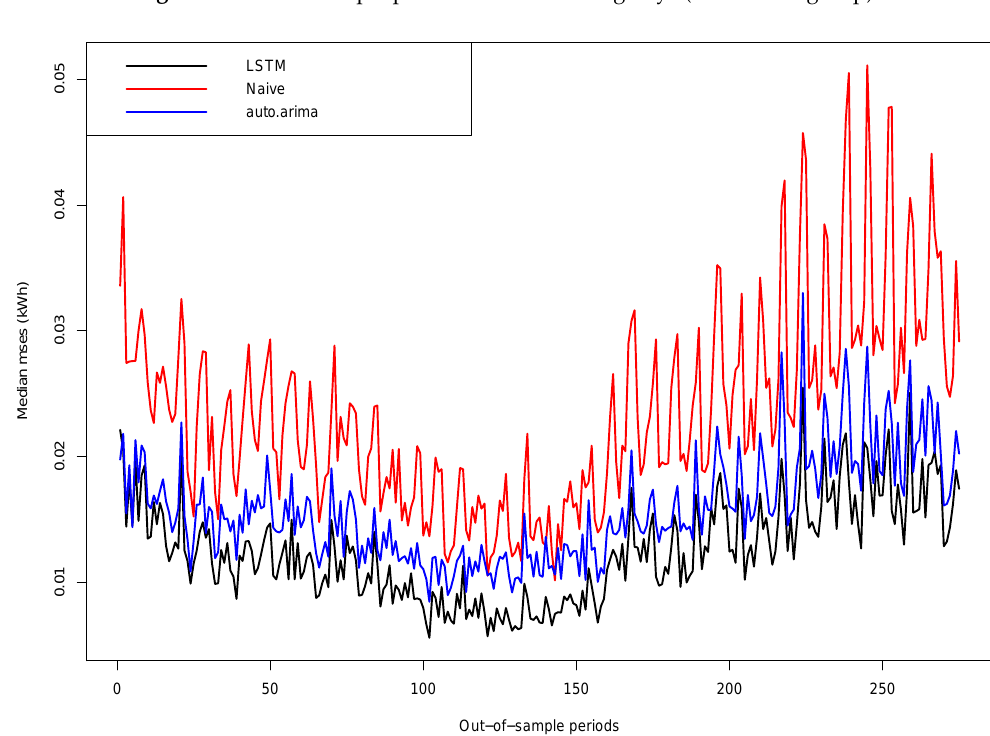
Figure 16. Out-of-sample performance for testing days (Global